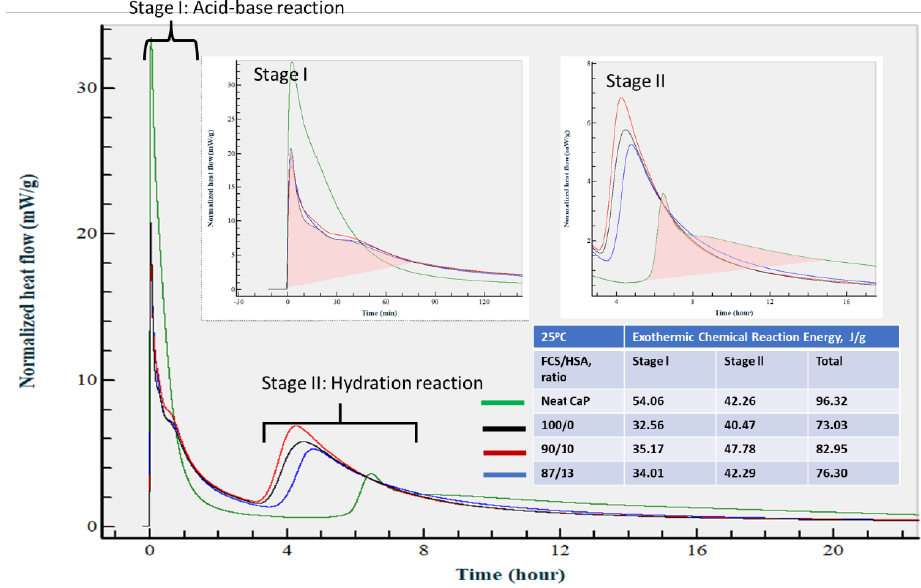
Figure 25. Calorimetric curves and normalized heat values for neat CaP cement and CaP composites made with FCS/HSA ratios of 100/0, 90/0, and 87/13 at temperature of 25 °C.